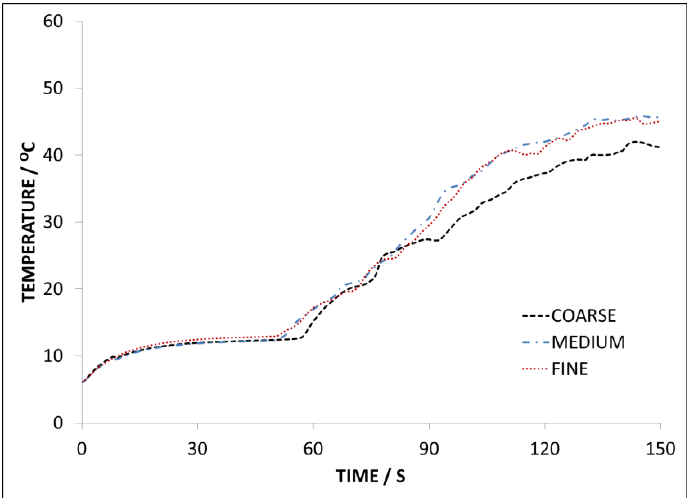
Figure 4. ThermocoupleT1 at 7m vertical height level transient simulation result comparisons for coarse, medium, and fine mesh systems.